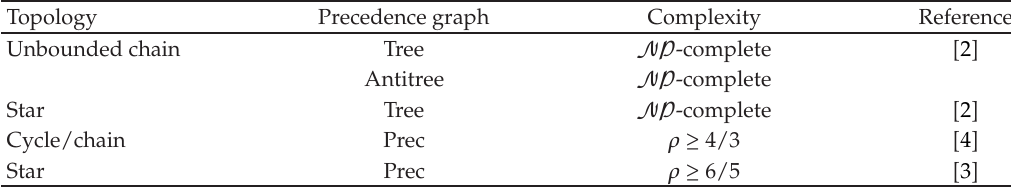
Table 1: Previous complexity results on the processors network